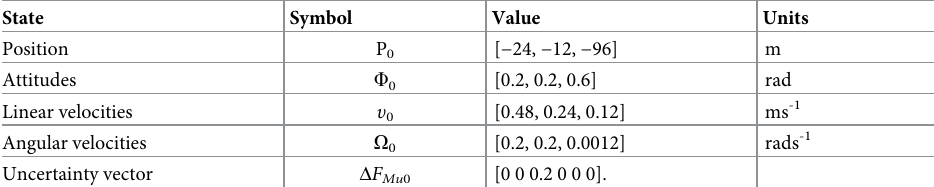
Table 2. Initial conditions for estimatior.